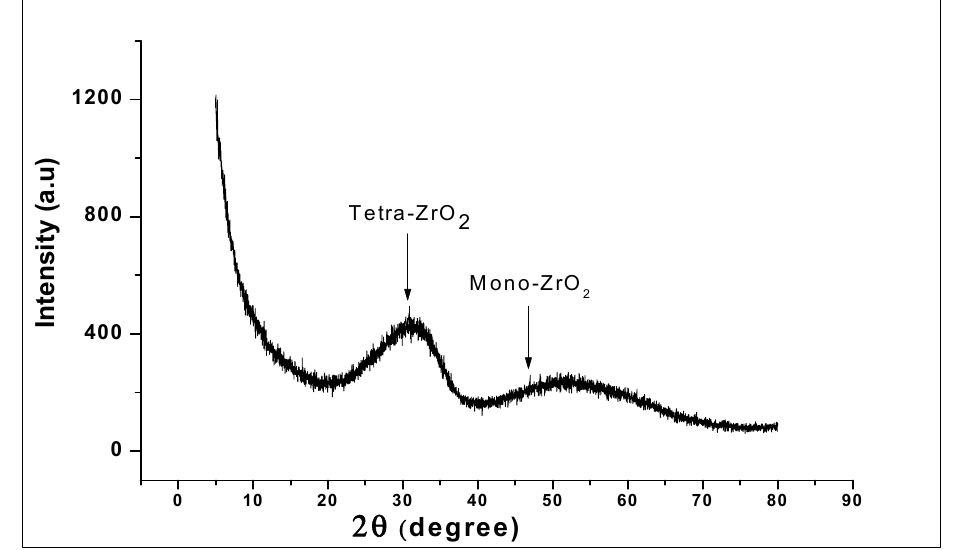
Figure 3. X-Ray Powder Diffraction (XRD) of ZrO 2 nanoparticles, showing the broad peaks corresponding to tetragonal ZrO 2 and monoclinic ZrO 2 structure.